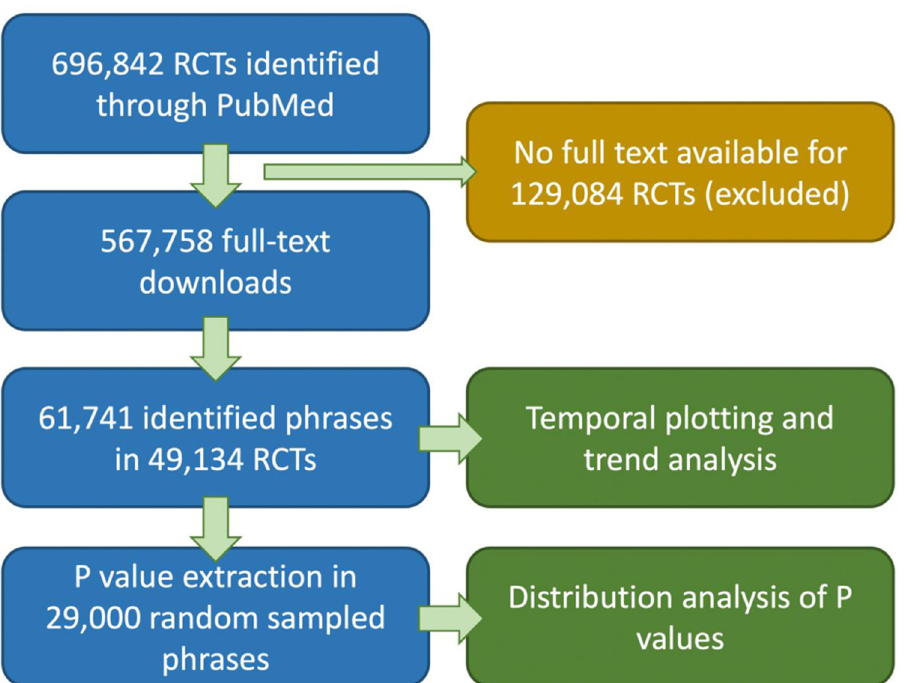
Fig 1. Flowchart of the study processing pipeline. R AU : AbbreviationlistshavebeencompiledforthoseusedthroughoutFigs 1 ; 2 ; 3 ; and 5 andTable 1 : Pleaseverifythatallentriesarecorrect : CT, randomized controlled trial.